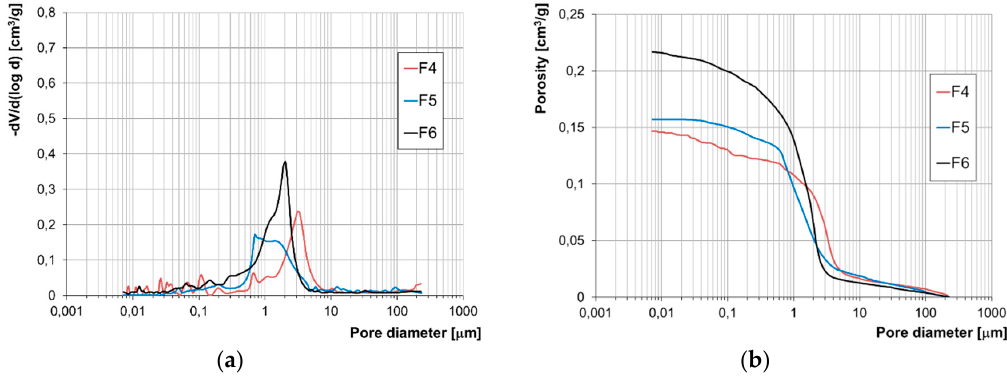
Figure 8. Pore size distribution ( a ) and cumulative curves of pores volume distribution ( b ) for flaking bricks F4, F5 and F6.